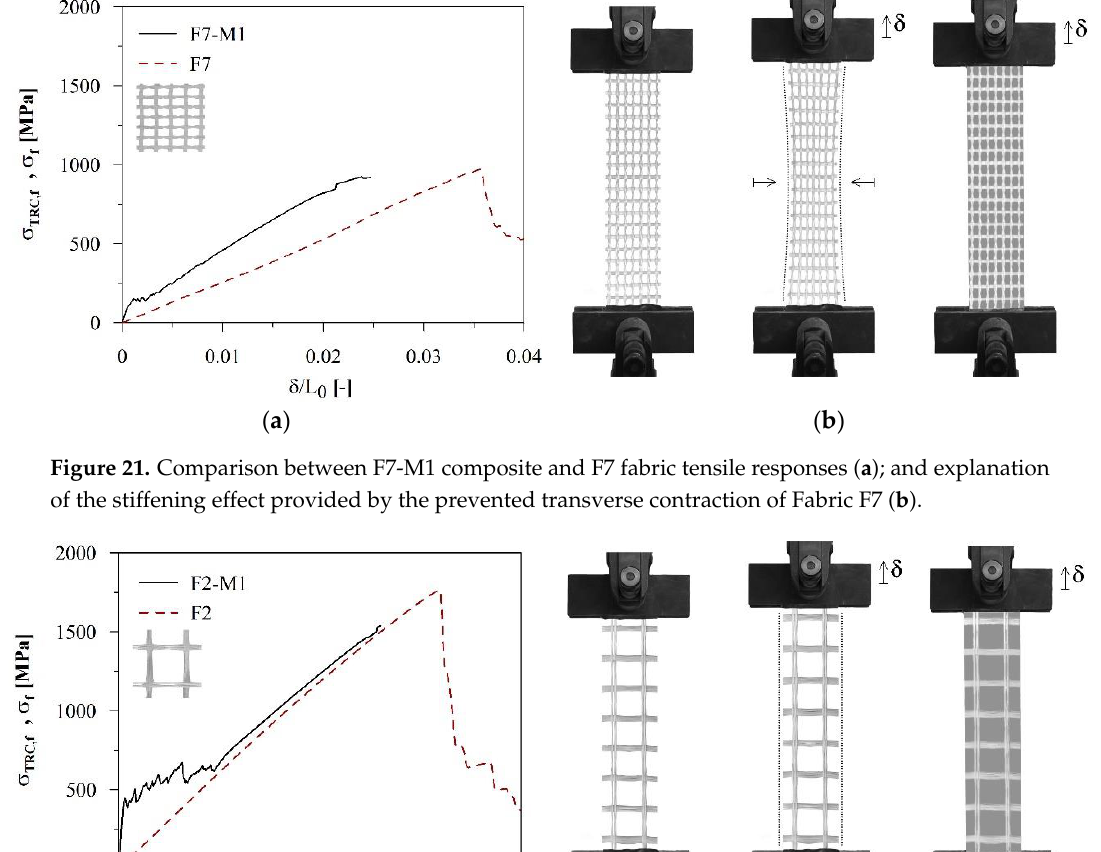
Figure 20. Comparison between the predicted analytical curves and the experimental responses in terms of nominal stress vs. strain for M1-based ( a ) and M2-based ( b ) composites reinforced with Fabric F7.